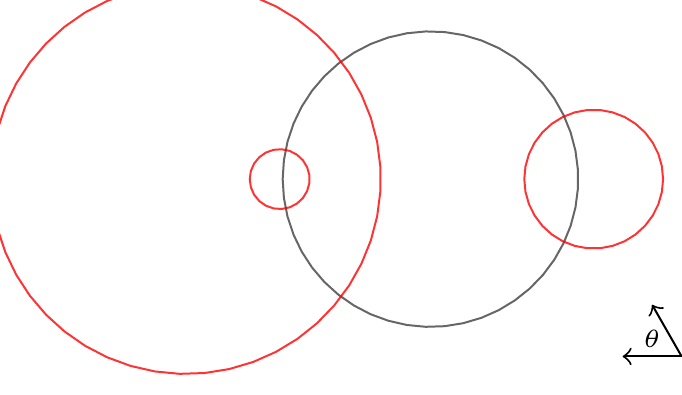
Figure 3 . Spheres (red) centered on the (cid:18) = 0 axis that intersect the boundary of H 2 (gray) orthogonally. The family of minimal caps obtained by restricting these spheres to the interior of H 2 form a foliation of H 2 : Points that are symmetric across the (cid:18) = (cid:25)= 2 plane lie on di(cid:11)erent spheres with the same radius (cid:26)